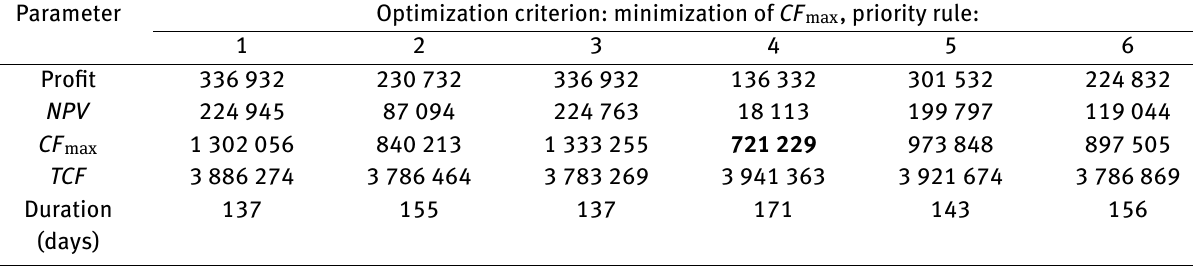
Table 7: Results for the minimization of CF max with selected priority rules. Parameter